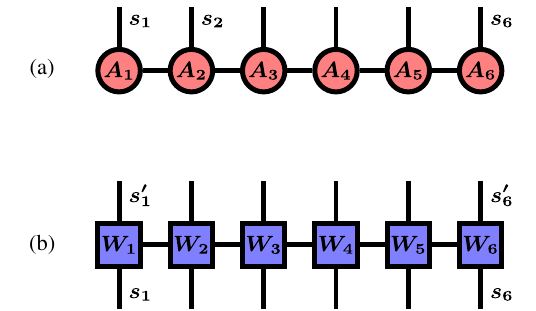
FIG. 1. (a) Graphical representation of a MPS. Every circle corresponds to a tensor A s i and each line to an index of this tensor. i In this picture, the physical indices are the vertical lines, while the horizontal lines show the bond indices. Connected lines mean that the corresponding index is summed over. Fixing all the physical indices s for each site results in a tensor of rank zero i with the value of the coefficient c . (b) Graphical repre- s 1 ; … ;s N sentation of a MPO. The difference from a MPS is that a MPO has incoming indices s and outgoing indices s 0 corresponding to the i i bra- and ket vectors of the